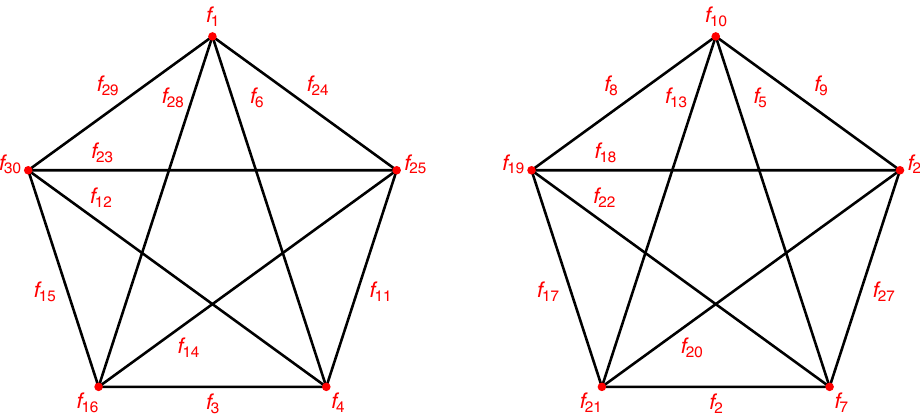
Figure 12 . These pentagons display some of the connections between the facets. The vertices of the pentagons correspond to facets that are tetrahedra. Each prism has two triangular facets and each of these is joined to a tetrahedron. The lines of the pentagons correspond to these prisms and show how they link to the tetrahedra. The two pentagons are interchanged by B , and A acts by rotation by 2 (cid:25)=